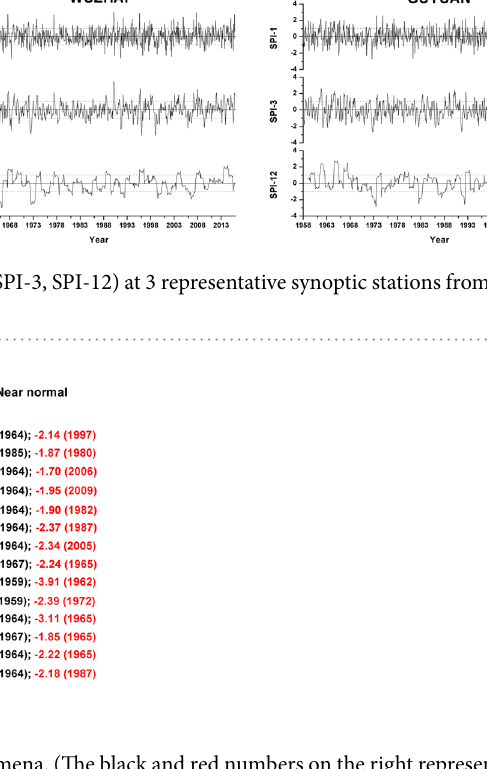
Figure 10. Frequencies of dry and wet phenomena. (The black and red numbers on the right represent the maximum and minimum SPI-12, respectively, and the corresponding year is given in